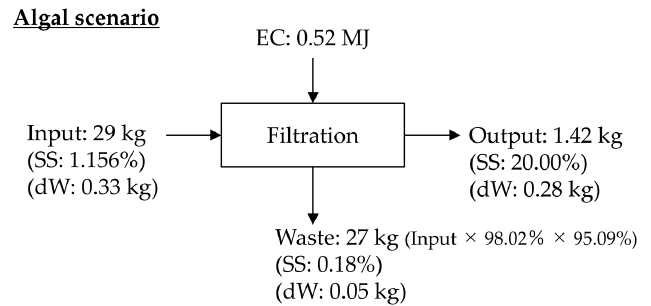
Figure 7. Drum filter equipment at Minamisoma (1.42 kW, 520 kg/h).